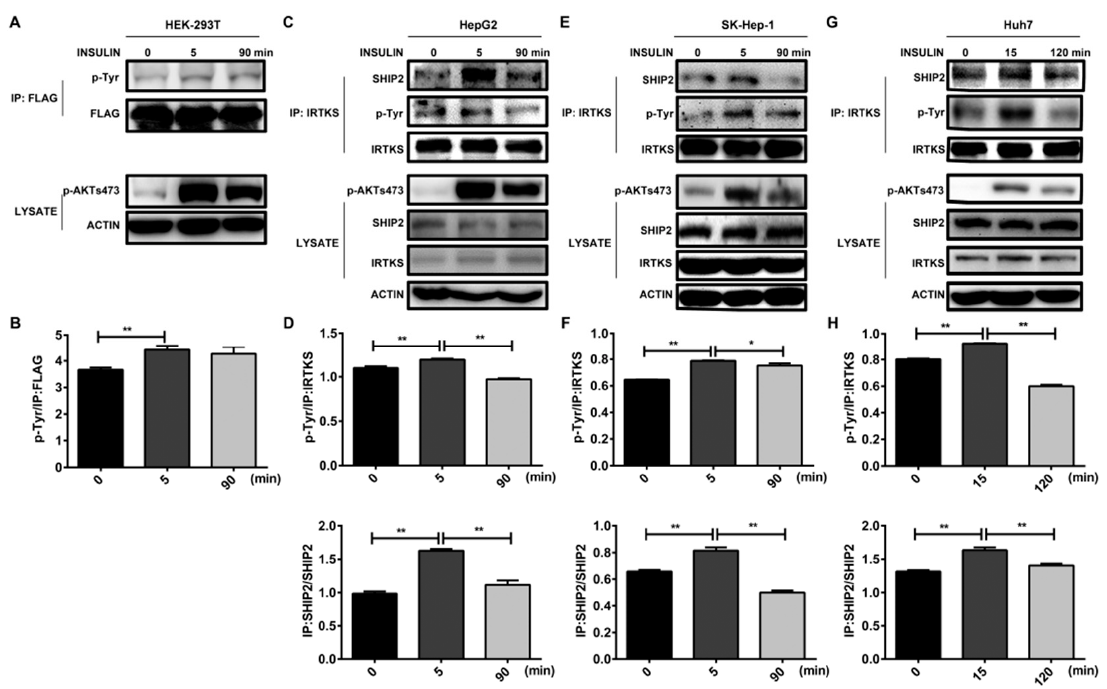
Figure 4. IRTKS dynamically interacts with SHIP2 under insulin stimulation. ( A , B ) Insulin stimulation increased the tyrosine phosphorylation of IRTKS. Flag–IRTKS fusion protein was expressed in HEK293T cells following insulin stimulation. After immunoprecipitation with FLAG M2 beads, Western blotting was performed to detect the tyrosine phosphorylation of IRTKS. ( C – G ) Insulin stimulation enhanced the endogenous IRTKS–SHIP2 interaction. The SHIP2 was immunoprecipitated by anti-IRTKS antibody in Huh7, SK-Hep-1, and HepG2 cells after insulin treatment ( C , E , G ). The tyrosine phosphorylation of IRTKS and the immunoprecipitated SHIP2 by anti-IRTKS antibody (IP: SHIP2) were quantitated based on the intensity of their bands, and then normalized according to total IRTKS and SHIP2 with three replicates, respectively ( D , F , H ). The data are shown as mean ± SD. * p < 0.05, ** p < 0.01 (Student’s t